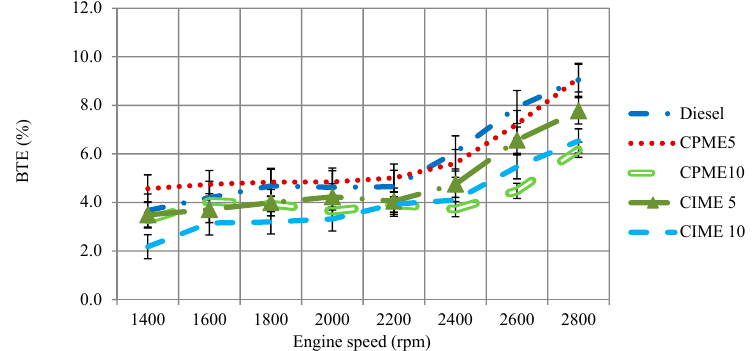
Figure 2. Changes in Brake Thermal Efficiency (BTE) of diesel, CPME, and CIME blends with speeds.